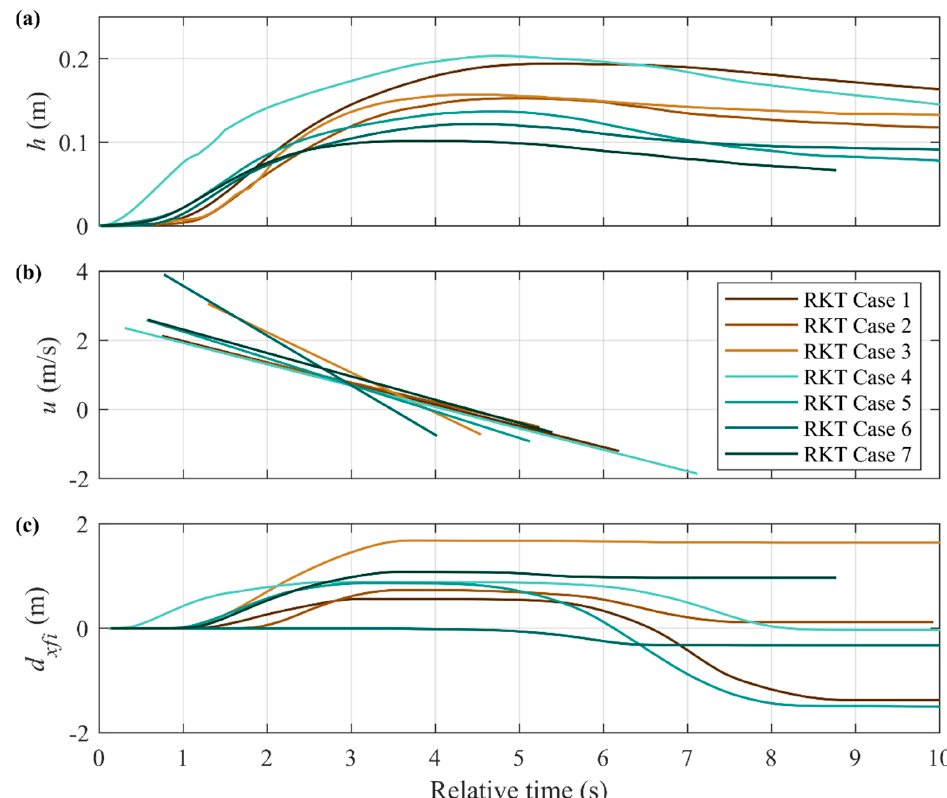
Figure 19. RKT single swash event field responses. ( a ) Measured water level at station 2. ( b ) Flow velocity at station 2 ( c ) IMU derived munition migration and final GPS munition position.